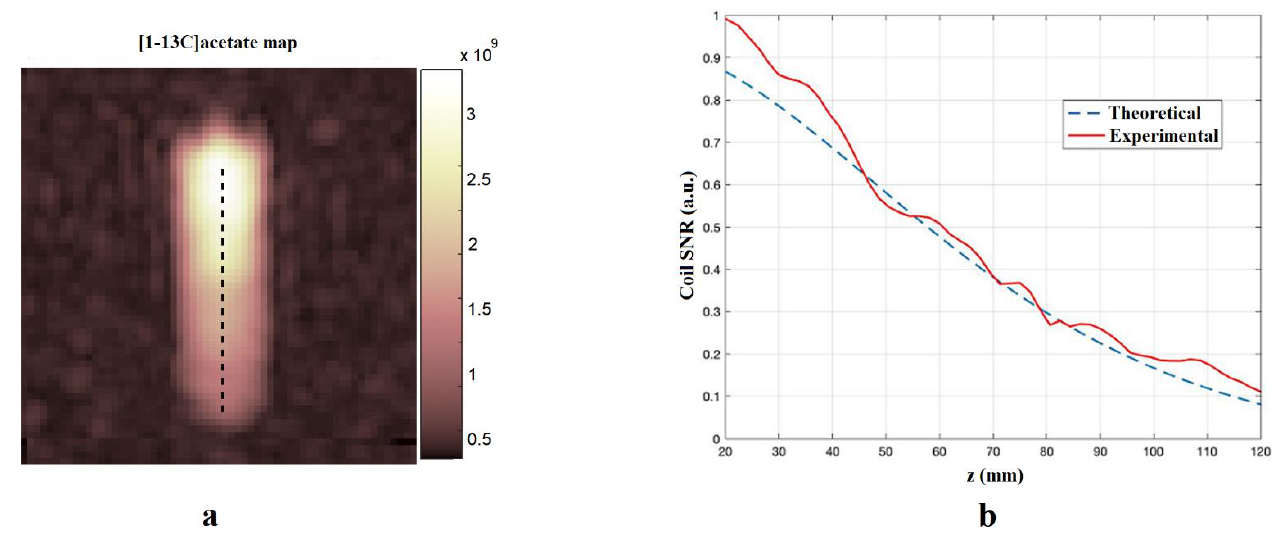
Figure 5. ( a ) [1- 13 C]acetate map, the dotted line shows which voxels are used to define the experimental SNR profile of Figure 4b; ( b ) Theoretical and experimental (along the line indicated in the phantom) SNR profiles [60].